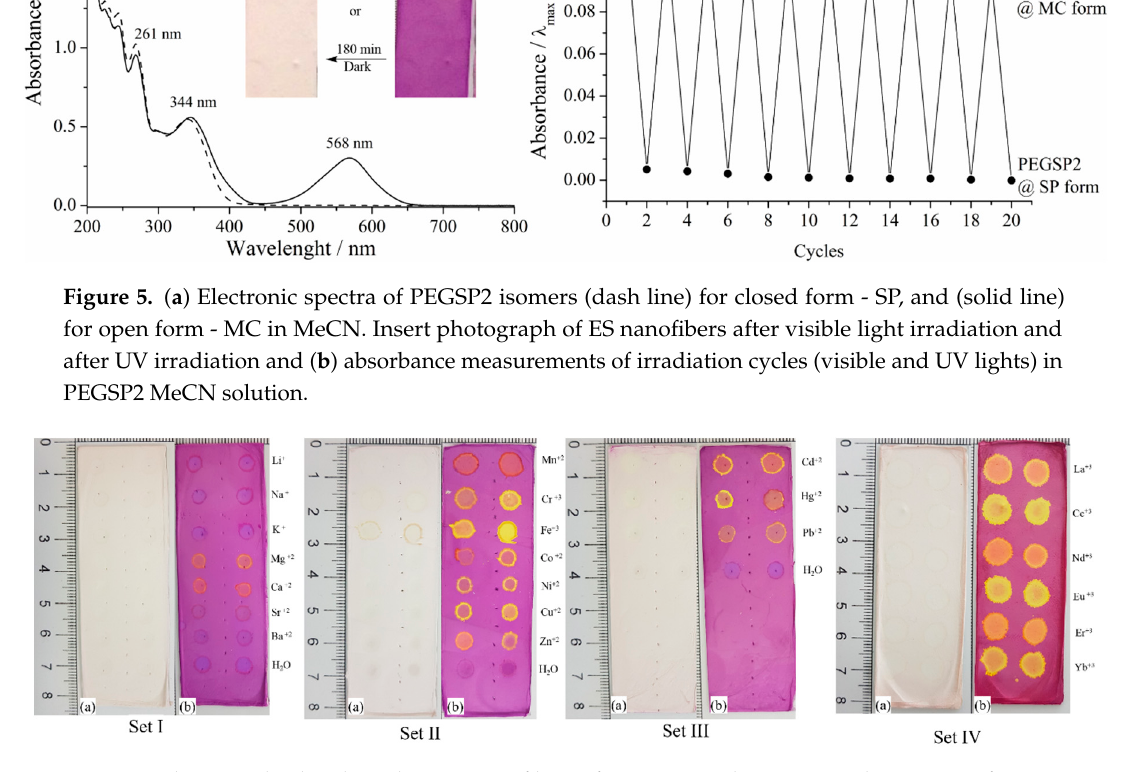
Figure 5. ( a ) Electronic spectra of PEGSP2 isomers (dash line) for closed form - SP, and (solid line) for open form - MC in MeCN. Insert photograph of ES nanofibers after visible light irradiation and after UV irradiation and ( b ) absorbance measurements of irradiation cycles (visible and UV lights) in PEGSP2 MeCN solution.